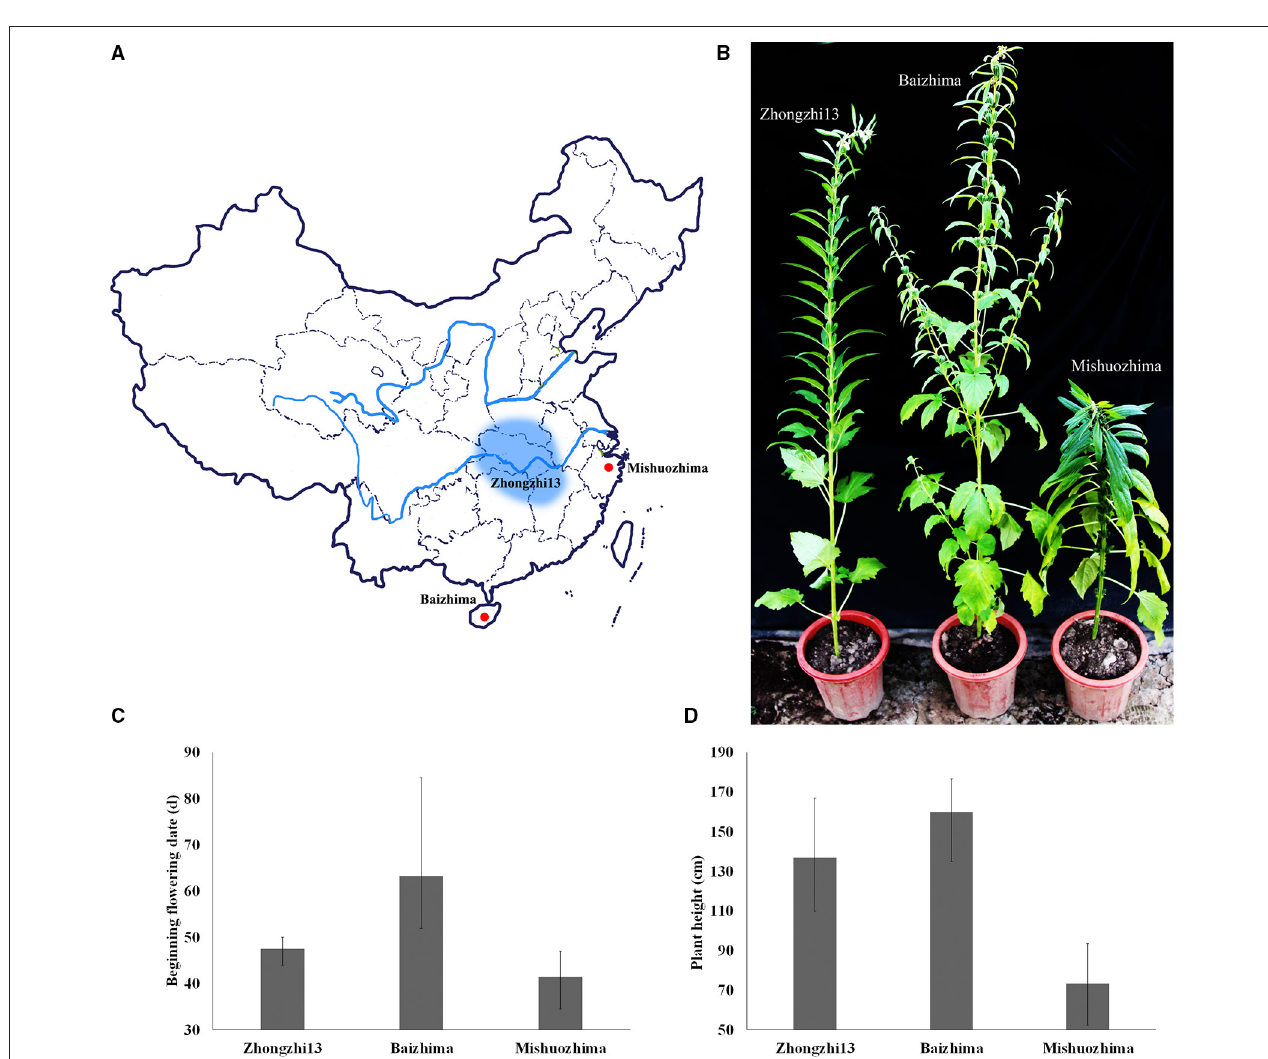
FIGURE 1 | Geographic origin and phenotypes of “Baizhima,” “Mishuozhima,” and “Zhongzhi13”. (A) Geographic origin; (B) Individuals in the end of flowering stage; (C) Beginning flowering date; (D) Plant height.